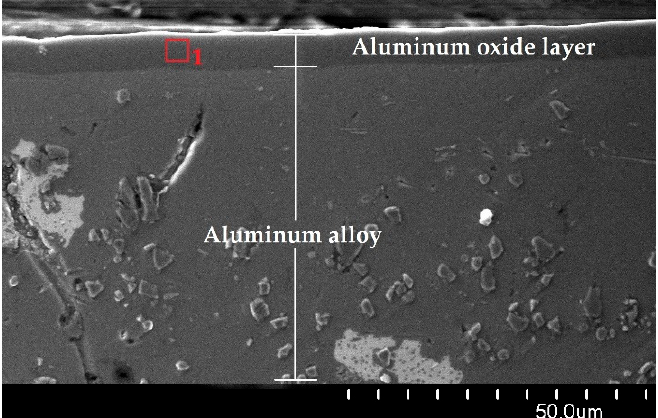
Figure 5. Cross-section of the oxide layer at a magnification of 1000× of sample A.